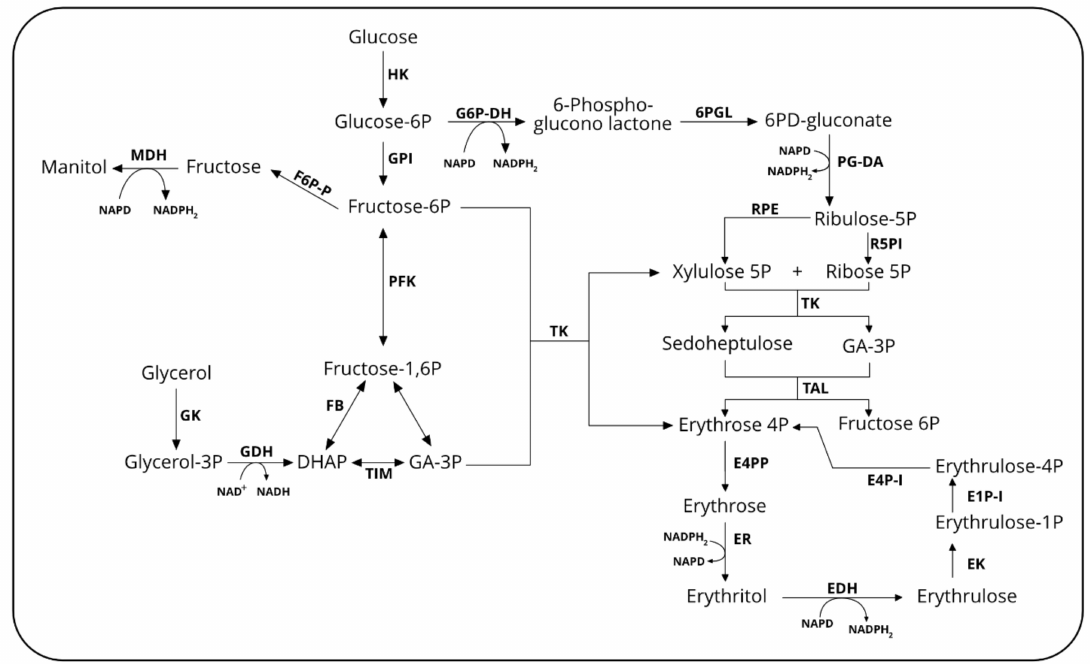
Figure 2. Overview of the principal metabolic pathways for polyols and derivatives synthesis in Y. lipolytica . DHAP: dihydroxyacetone-P; E4PP: Erythrose 4P phosphatase; ER: erythrose